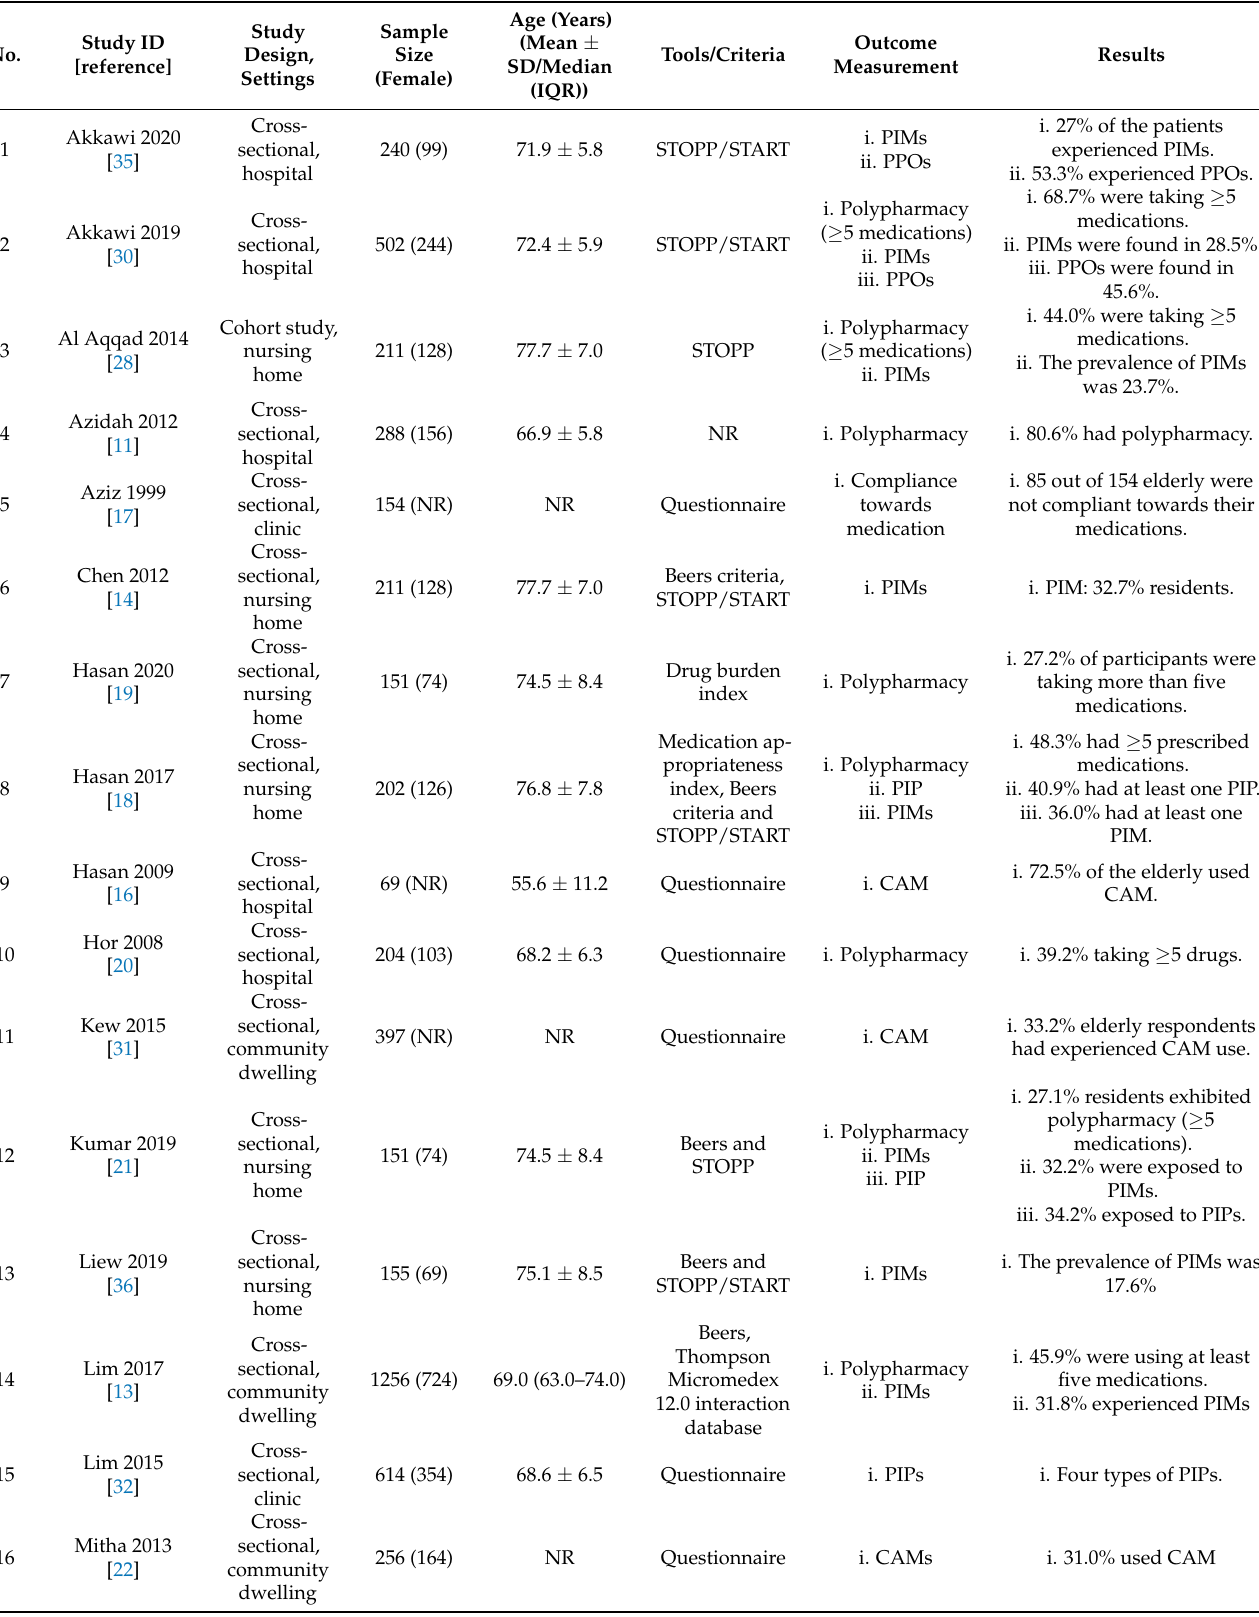
Table 1. Major characteristics of the included